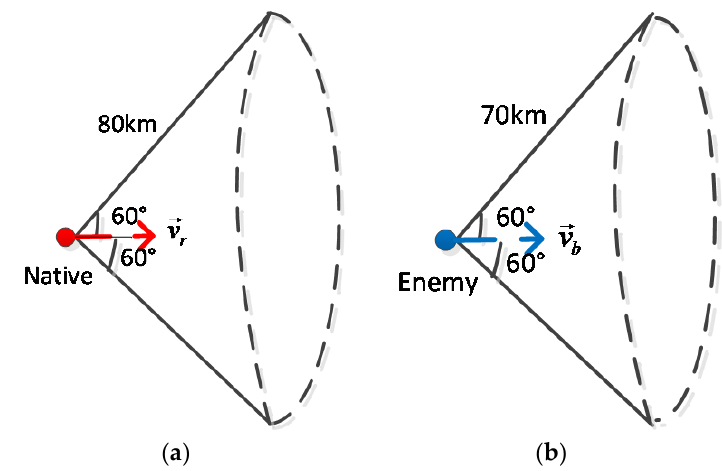
Figure 2. The radar detection area of both sides. ( a ) Native radar; ( b ) Enemy radar.